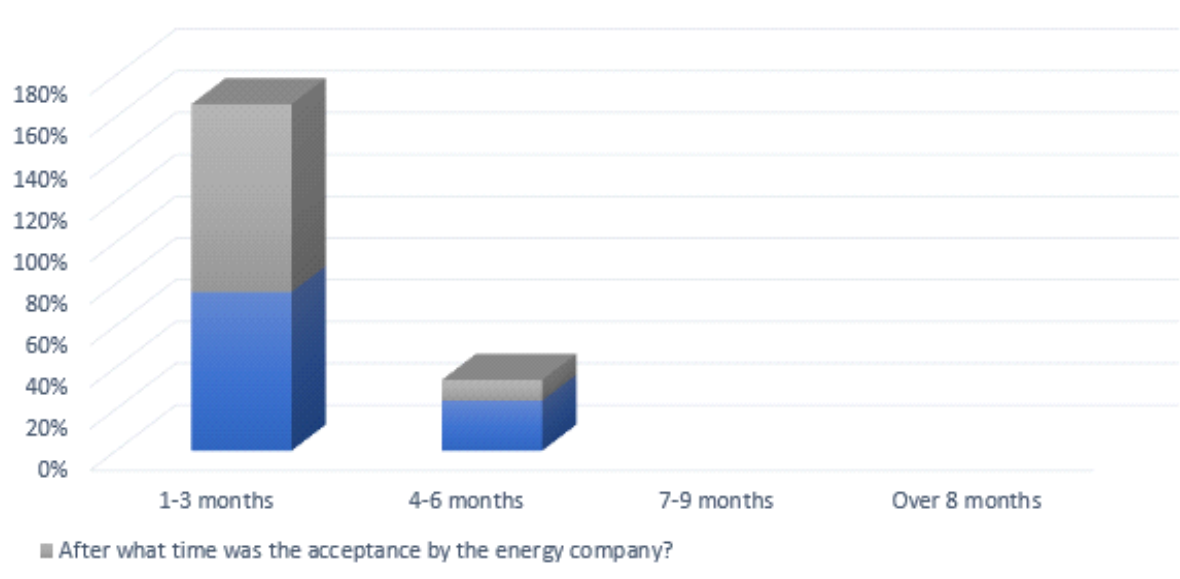
5 of 23 Figure 4. Time-decision process of purchasing a photovoltaic installation.